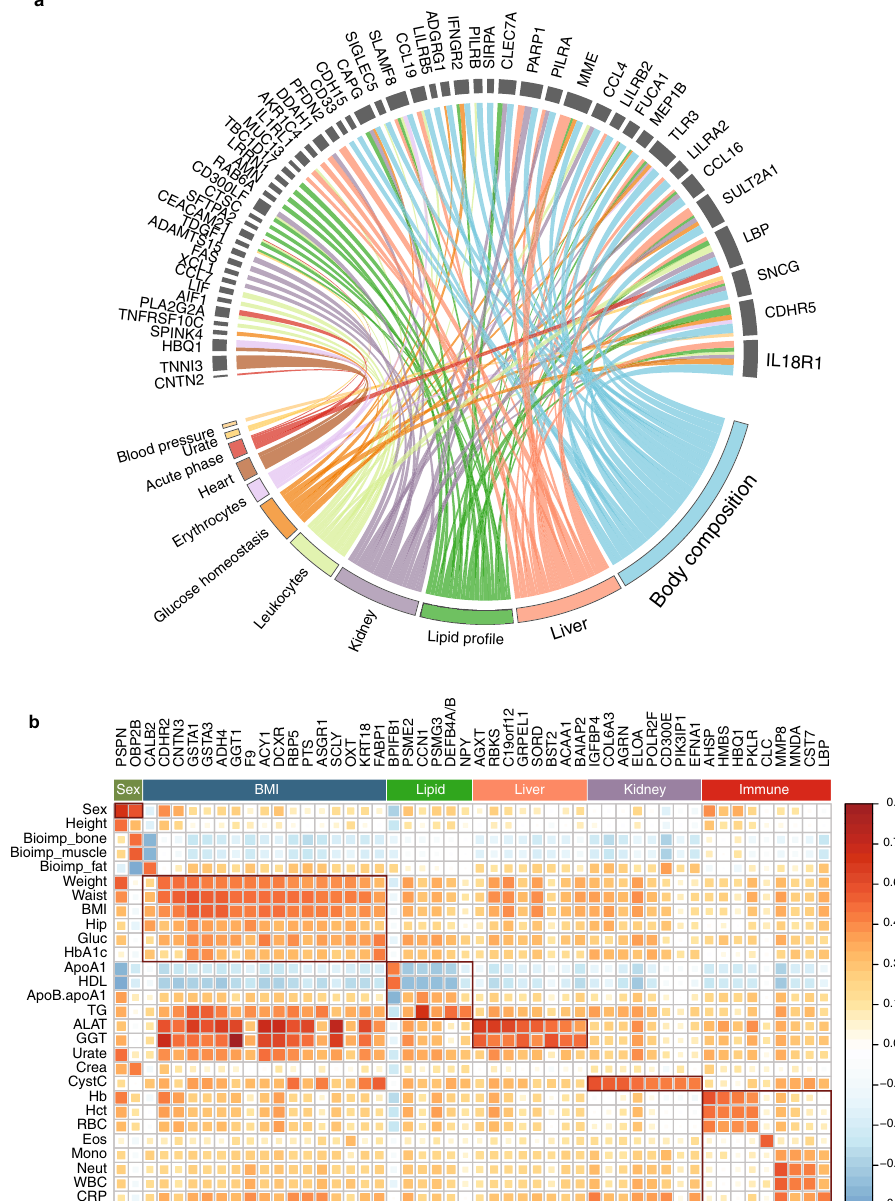
Fig. 4 Associations of proteins with clinical assays. a Chord diagram presenting the 53 proteins with pQTLs related to clinical measurements. The size of the link is de fi ned as the absolute value of coef fi cient of the corresponding effect (mixed-effect modeling analysis for each protein and clinical measurement adjusted for gender, age and visit). b A heatmap showing the top 50 proteins most strongly associated with clinical assays based on both wellness and T2D cohorts. Only proteins who are exclusive in the PEA-NGS are listed. See complete results of the pairwise Pearson correlation values between all proteins and clinical assays in Supplementary Data 7. Source data are provided as a Source Data fi These proteins are thus potential plasma protein biomarkers for three groups based on the response of therapeutic intervention, as identifying individuals with high risk for T2D in population determined by the decreased level of fasting plasma glucose screens independent on BMI. A principle component analysis (FPG) after three months treatment (Fig. 6a). The groups inclu- (PCA) based on the 32 differentially expressed proteins shows ded responders (FPG decrease >1), non-responders (FPG that the T2D patients clustered together, regardless of anthro- decrease <0.1) and an indeterminate group (FPG decrease pometrics parameters (BMI), and separate from the healthy between 0.1 and 1). Of note, one patient with large and opposite individuals, using the combined protein pro fi le of this panel of 32 changes of FPG in visit 2 ( − 2.8) and visit 3 (1.6) was also grouped proteins. into the indeterminate group. Changes of plasma levels during diabetes treatment as well as the comparison with healthy indi- viduals in the top 50 most highly associated proteins with fasting Strati fi cation of T2D patients with regards to response to glucose are present in Supplementary Fig. 4. As shown, the metformin treatment . Among the T2D patients, 40 individuals treatment results in partial recovery towards normal protein were treated with metformin and here we strati fi ed these into